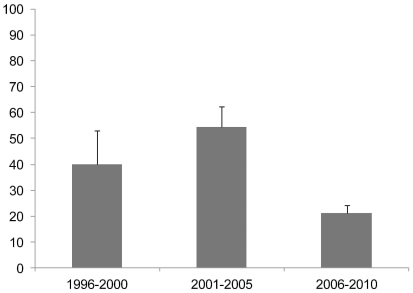
Seropositivity of Toxoplasma gondii (95% confidence limits) in wild birds from Spain among periods (years) of sampling.